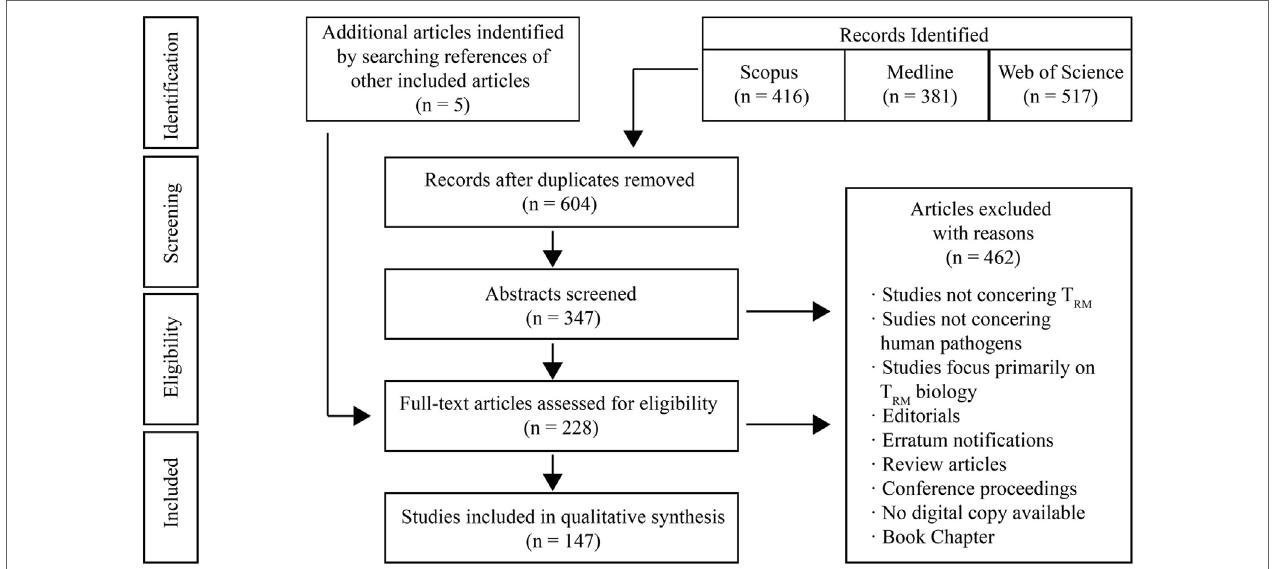
FiguRe 1 | Literature search strategy. The search strategy used revealed 381 records in Medline (Ovid), 416 in SCOPUS, and 517 in Web of Science. This resulted in a total number of 1,314 records. After removing duplicates, there were 604 records. Screening of titles resulted in the exclusion of 257 records, as they did not address resident memory T cells, human infectious diseases, or neither. Others records were excluded as they were reviews, editorials, meeting abstracts, book chapters, poster presentations, or erratum notifications. The abstracts of the remaining 347 records were analyzed and a further 124 publications were excluded due to their focus on T RM biology. The full texts of the remaining studies were reviewed. 81 of these texts were excluded for aforementioned reasons. Co-authors were consulted when there was ambiguity regarding the relevance of a study. In total, 142 publications from the search were included. 5 additional studies were included by screening the references of studies from the search results and following external